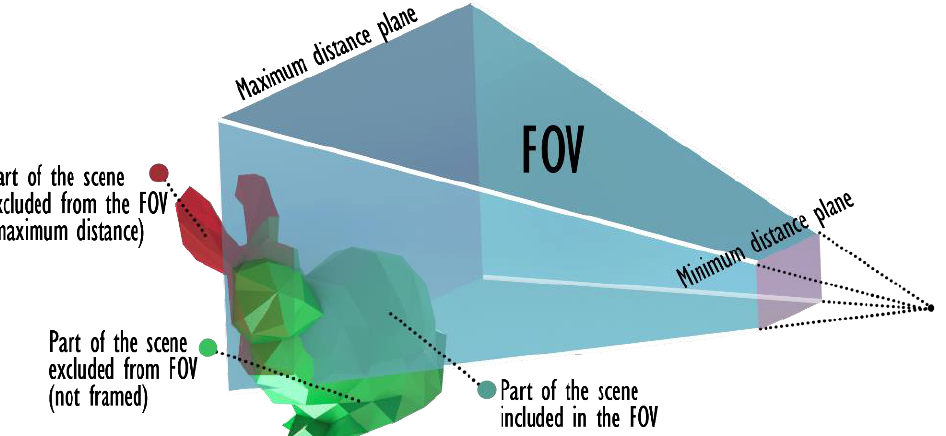
Figure 3. E ff ect induced by the CropFov Figure 3. Effect induced by the CropFov filter. Figure 3. Effect induced by the CropFov filter.